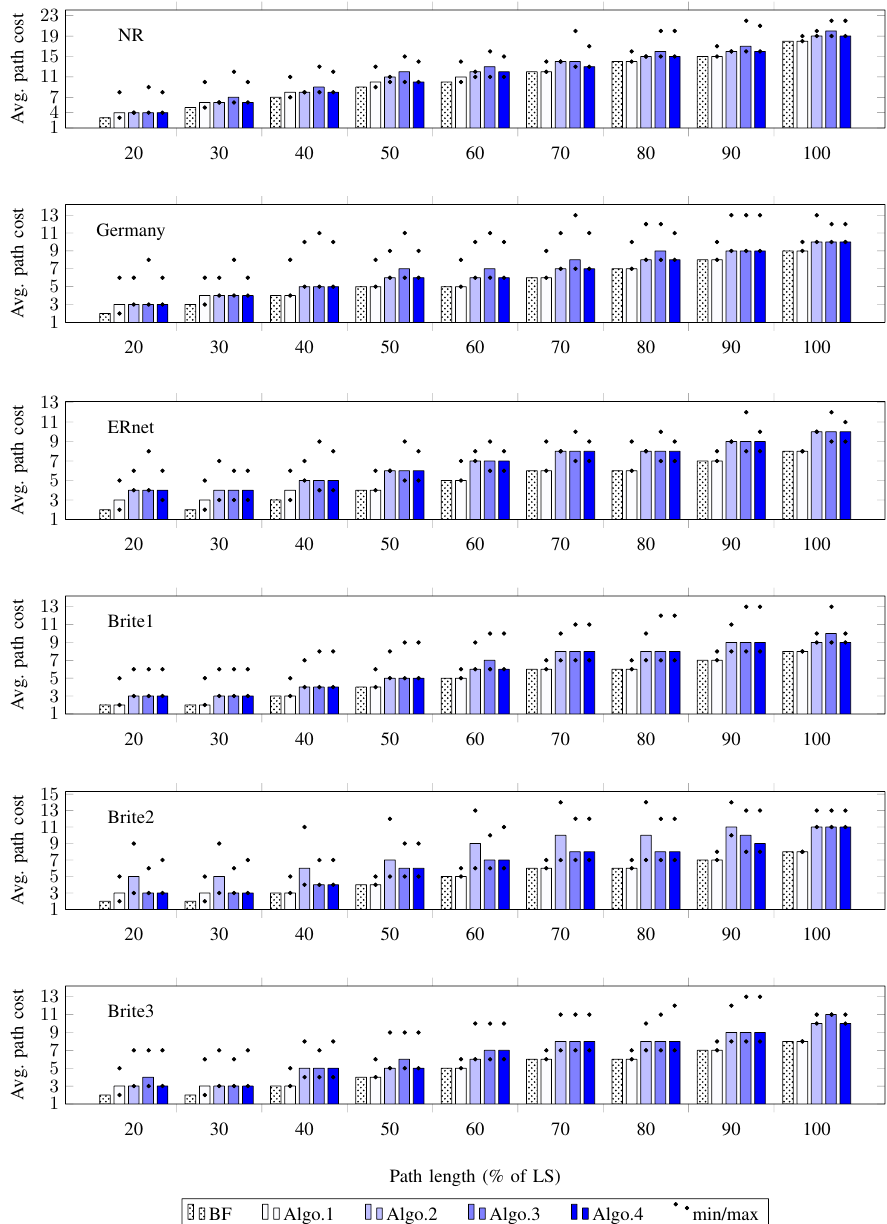
Fig. 6. The average path cost, i.e. number of hops, achieved by Algorithms 1, 2, 3 and 4 for the experimental topologies of Table I Figure 6. The average path cost, that is, number of hops, achieved by Algorithms 1–4 for the experimental topologies of Table